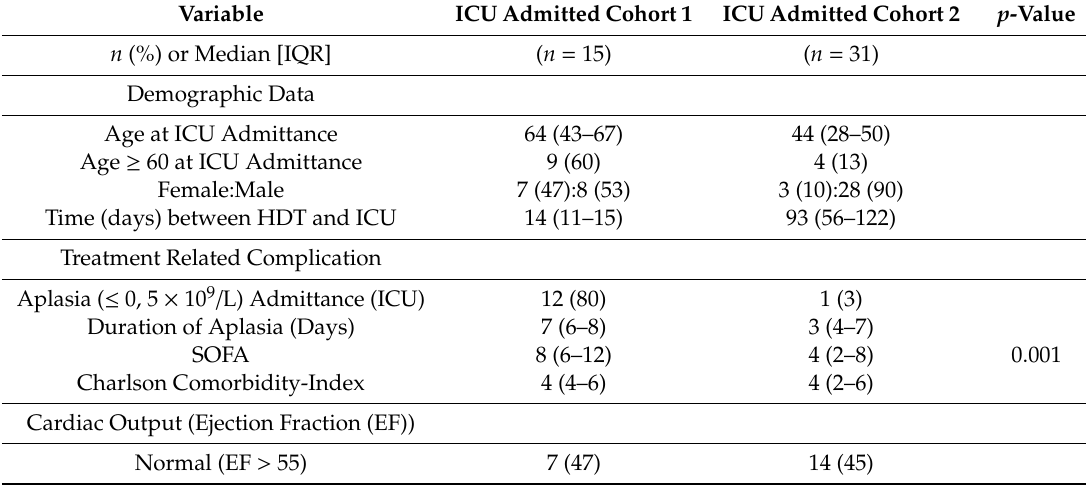
Table 2. Demographic data and clinical parameters of patient. Cohort 1: patients admitted to the ICU due to immediate complications during HDT and ASCT treatment. Cohort 2 patient admitted within 6 months after high dose chemotherapy and ASCT (excluding cohort 1 patients).